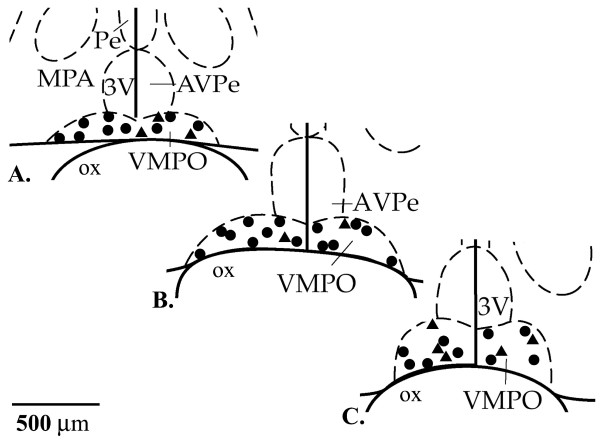
Intracellular whole-cell recordings from VMPO Neurons. The positions of all recorded neurons in this study are indicated on the above coronal diagrams (temperature insensitive = ●, warm sensitive = ▲ modified from Figures 18–20, Paxinos & Watson, 1998). A corresponds to the anterior regions of VMPO, approximately 400 μm rostral to the areas shown in B, which correspond to the midpoint of the VMPO. C corresponds to the posterior regions of VMPO, approximately 400 μm caudal to the areas shown in B. 3 V, third ventricle; AVPe, anteroventral periventricular nucleus; MPA, medial preoptic area; Pe, periventricular hypothalamic nucleus; ox, optic chiasm; VMPO, ventromedial preoptic nucleus.